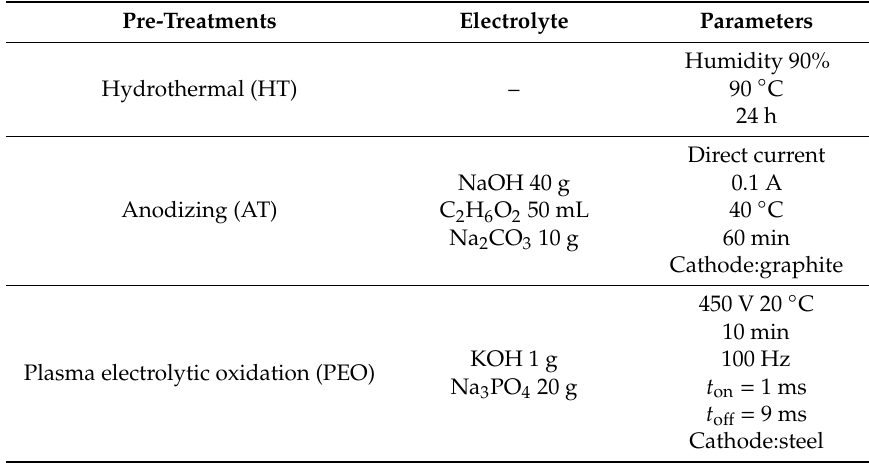
Table 2. Details of the pre-treatments on pure